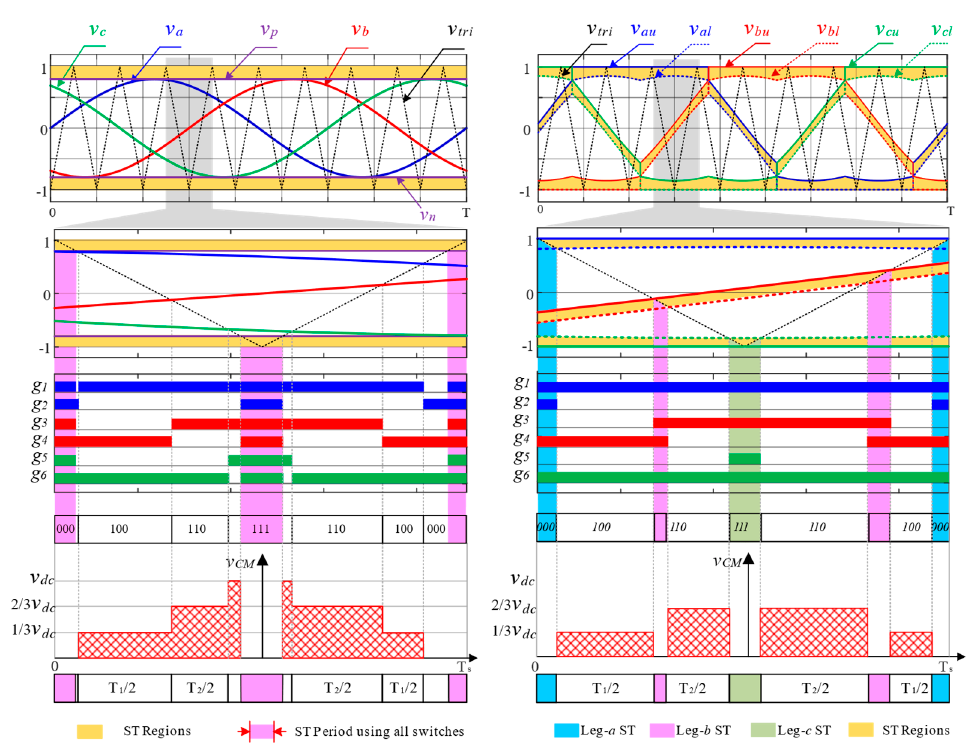
Figure 8. The CMV waveform in QZSI.